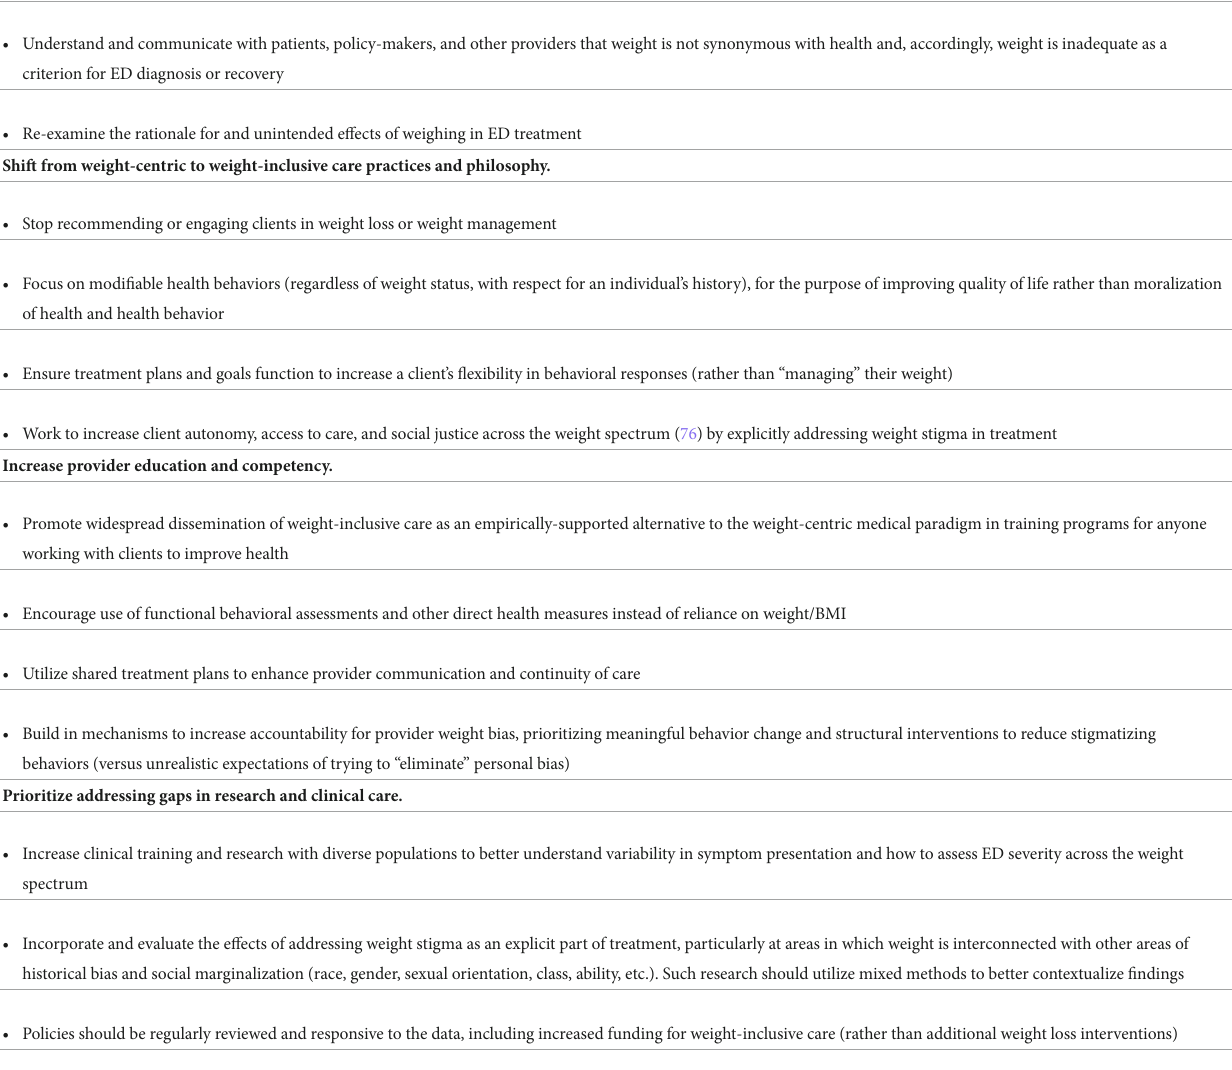
Acknowledge the influence of weight stigma on current ED